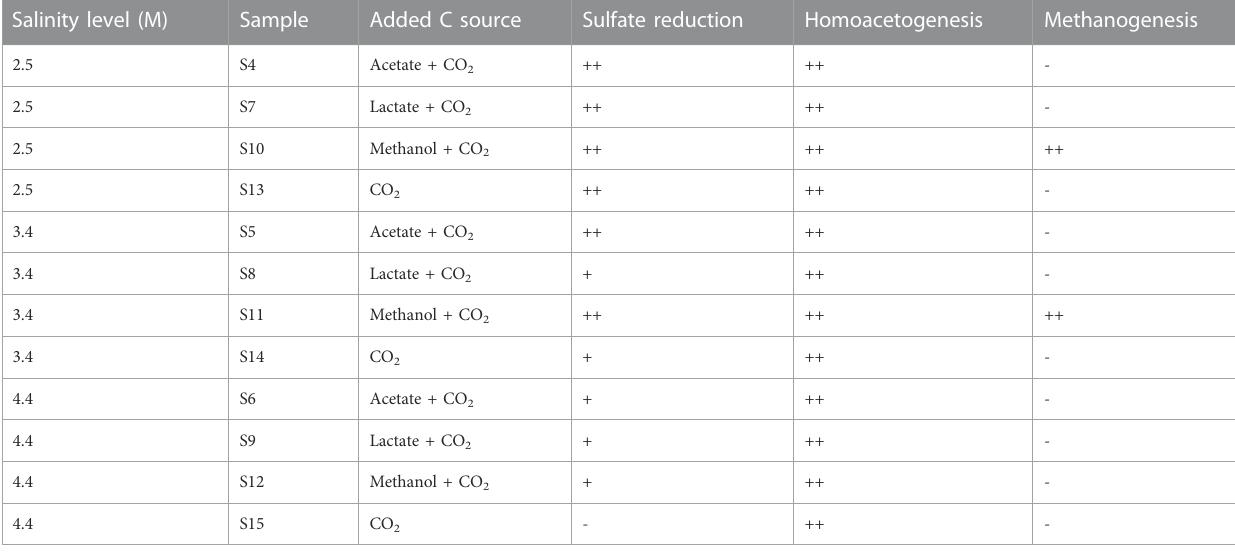
TABLE 1 Metabolic reactions at different salinity levels and with different C sources. The metabolic reactions shown in Figure 1 and Supplementary Figure S1 are listed. Complete sulfate consumption and occurrence of aceto- and methanogenesis within the incubation period of 125 d are indicated with (++), incomplete sulfate consumption and sulfate consumption post 125 d is indicated with (+). No occurrence within 1445 d is indicated with ( − ). Salinity level